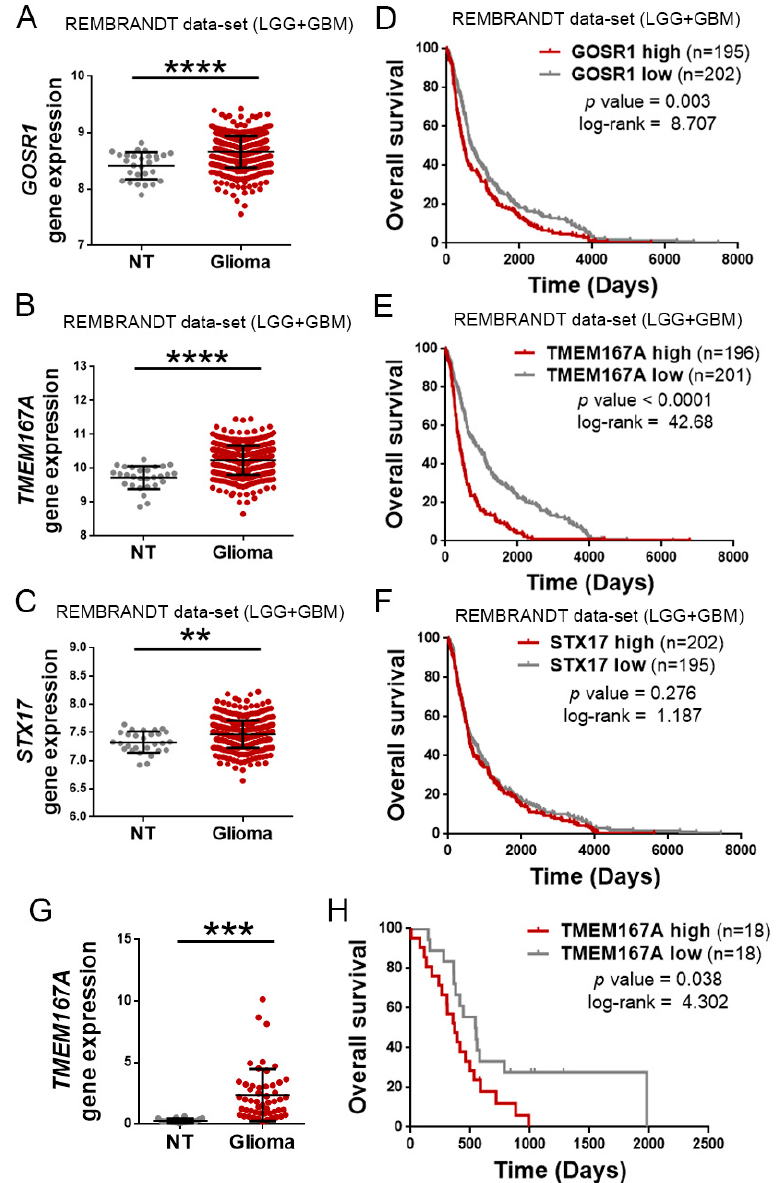
Figure 2. TMEM167A is overexpressed in gliomas and correlates inversely with tumor aggressiveness. Analysis of the amount of GOSR1 ( A ), TMEM167A ( B ), and STX17 ( C ) mRNAs levels in gliomas (LGG + GBM Rembrandt cohort) compared with normal tissue. ( D–F ) Kaplan–Meier overall survival curves of patients from the Rembrandt LGG + GBM cohort. Patients were separated on the basis of high and low GOSR1 ( D ), TMEM167A ( E ), and STX17 ( F ) gene expression values. ( G ) qRT-PCR analysis of TMEM167A in our own cohort of glioma samples ( n = 52) compared with normal tissue. HPRT expression was used for normalization ( H ) Kaplan–Meier overall survival curves of patients from our own glioma cohort ( n = 36). Patients in each cohort were stratified into 2 groups on the basis of high and low TMEM167A expression values. ** p ≤ 0.01, *** p ≤ 0.001, **** p ≤ 0.0001.